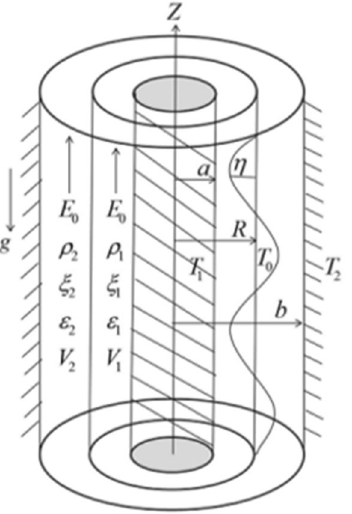
Figure 1. Description of natural prototype of the